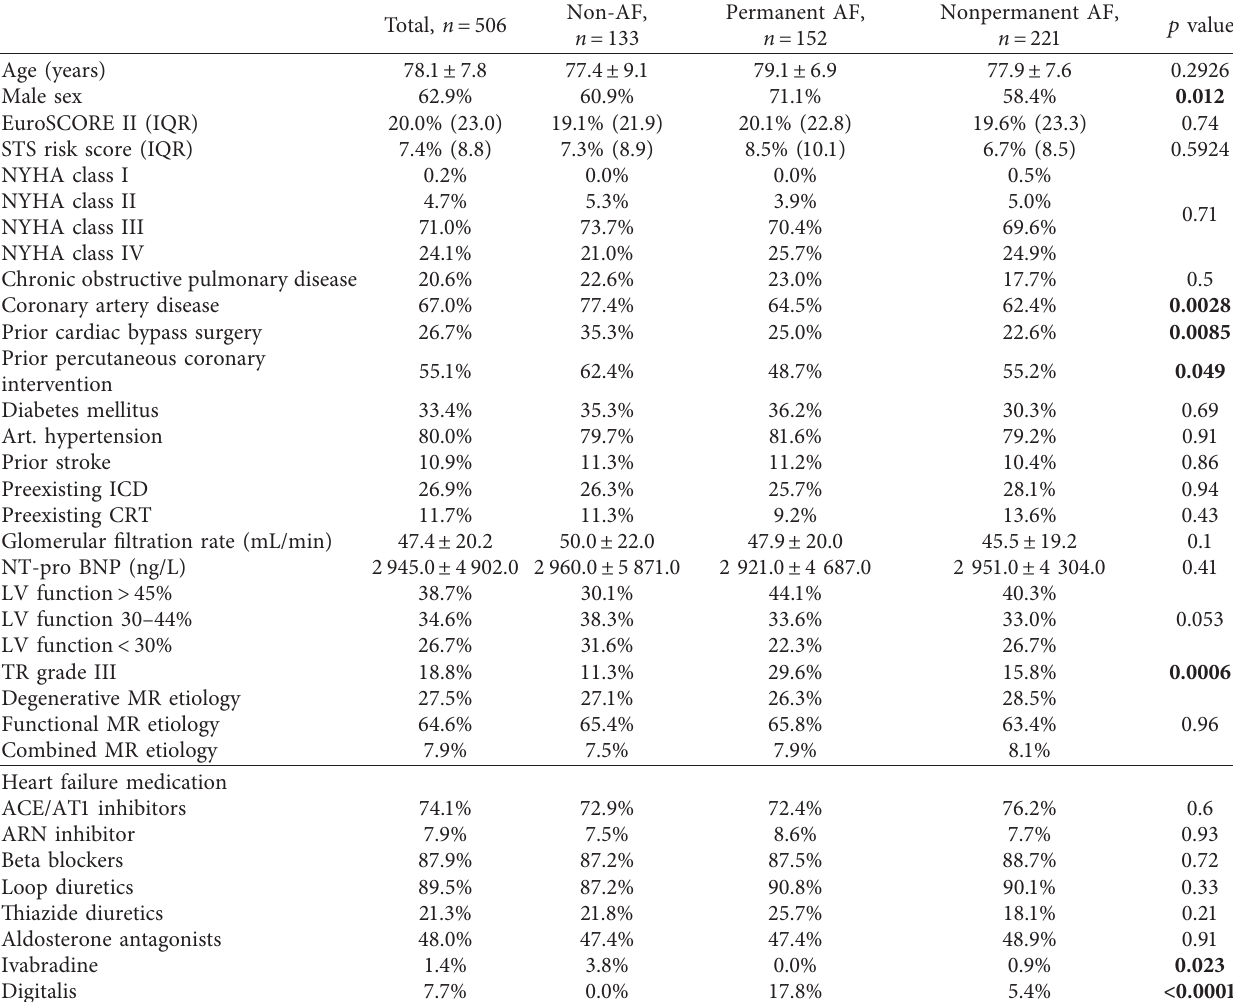
Table 1: Clinical characteristics and heart failure